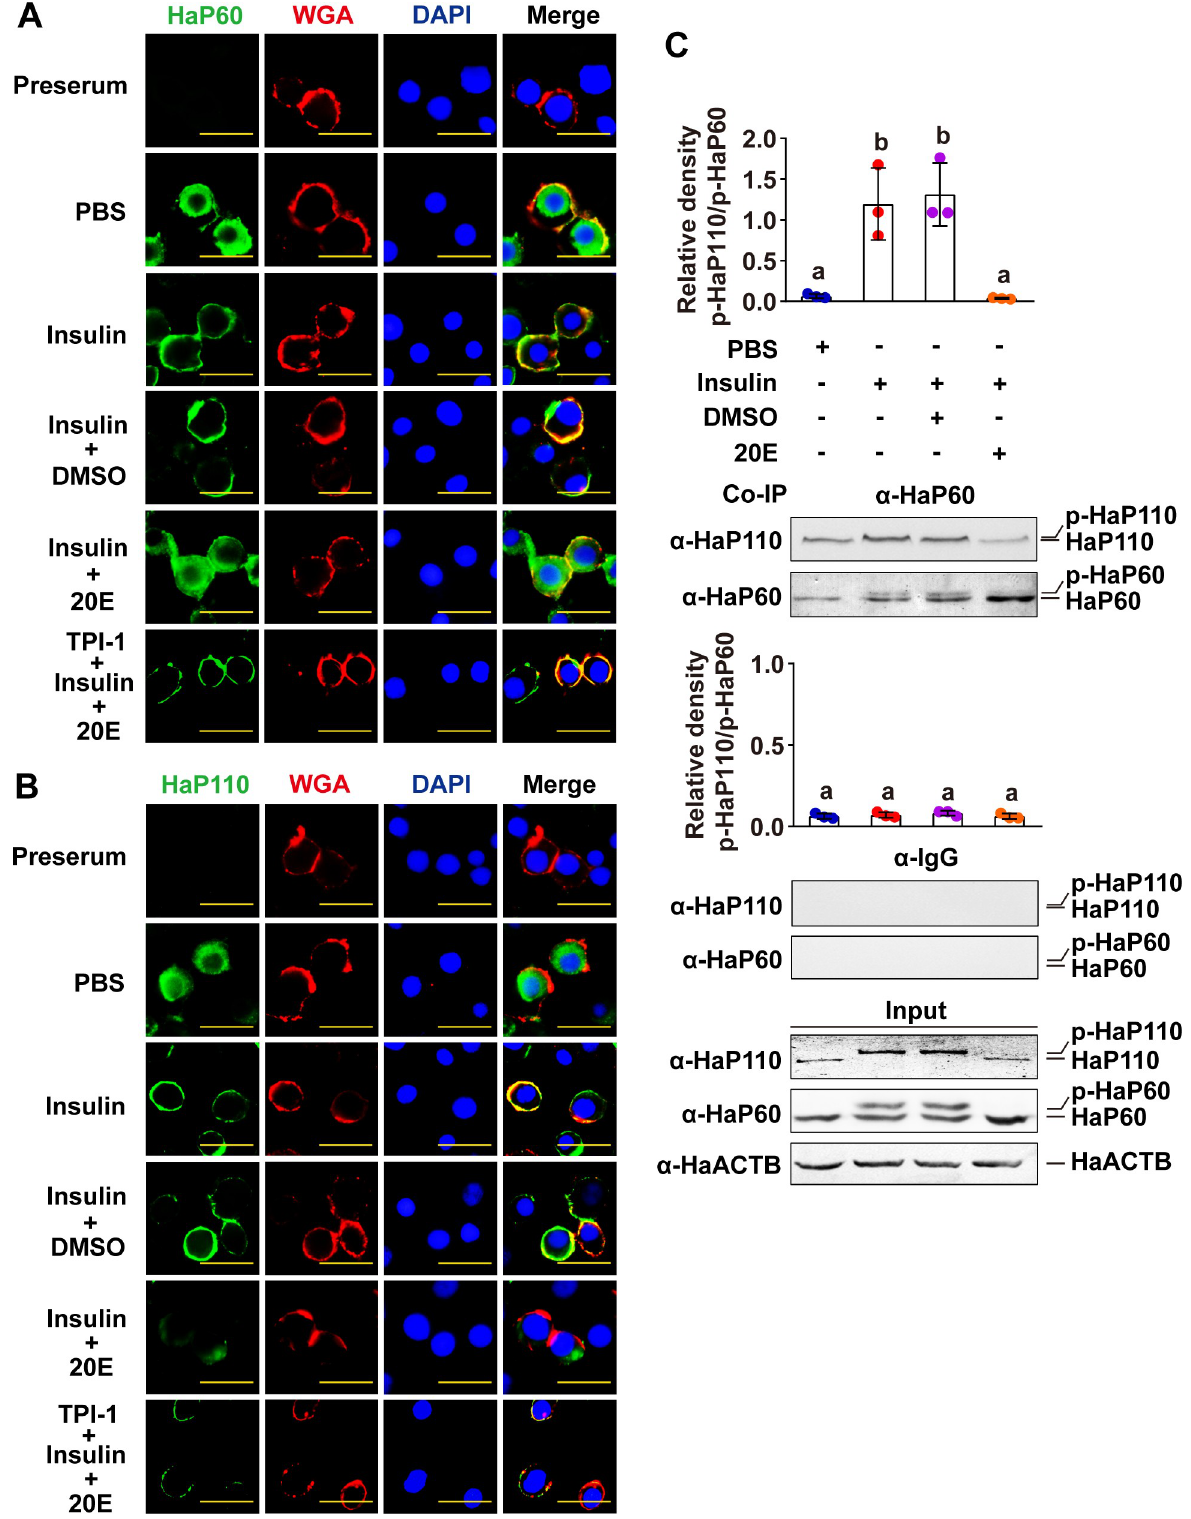
Fig 4. 20E repressed ILP-mediated cell membrane translocation of HaP60 and HaP110, dephosphorylated HaP60 and HaP110, and decreased their interaction. A and B. Immunocytochemistry showed that 20E repressed insulin-mediated HaP60 and HaP110 cell membrane localization